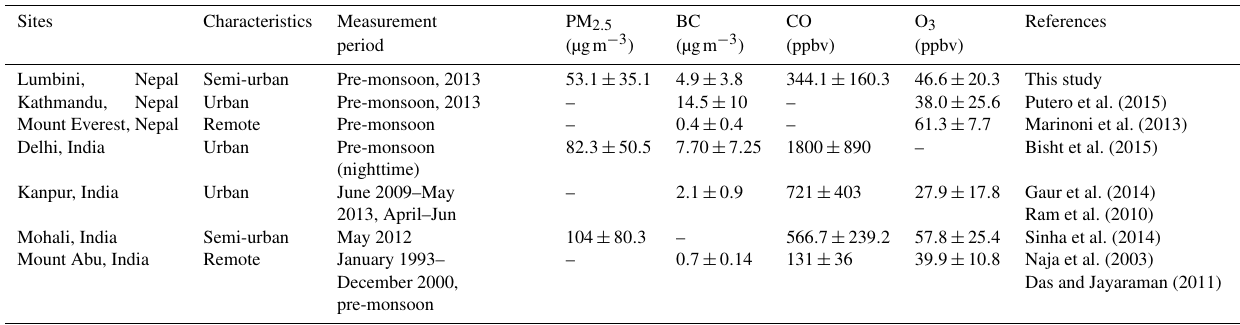
Table 2. Comparison of PM 2 . 5 , BC, CO and O 3 concentrations at Lumbini with those at other sites in South Asia.